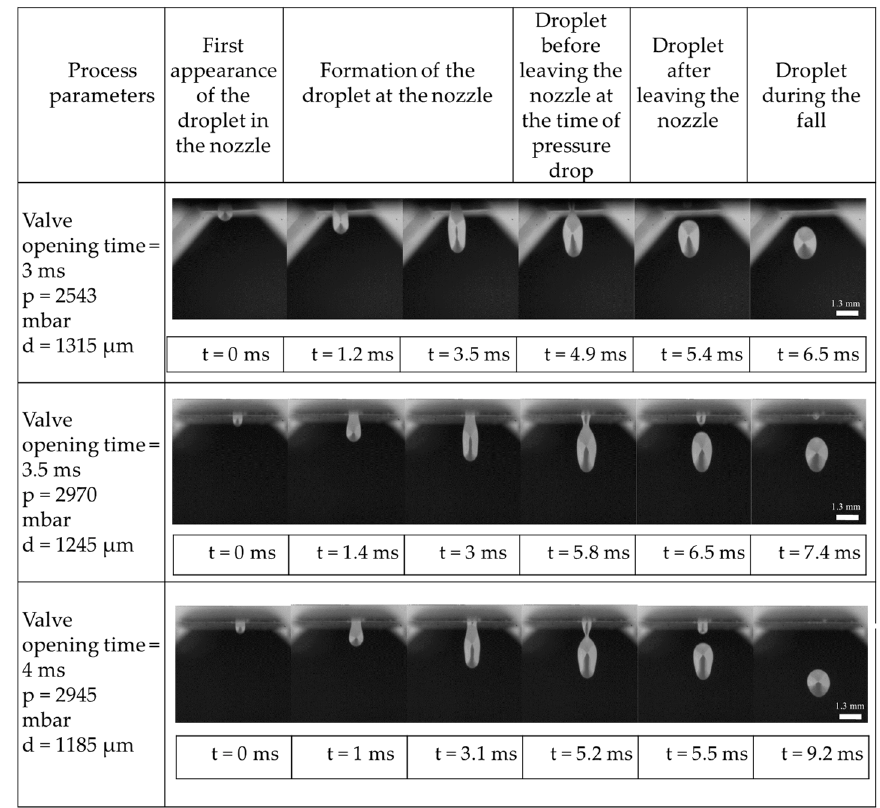
Figure8. Dropletformationmodesfordi ff Figure 8. Droplet formation modes for different valve opening times and corresponding feed pressures p.